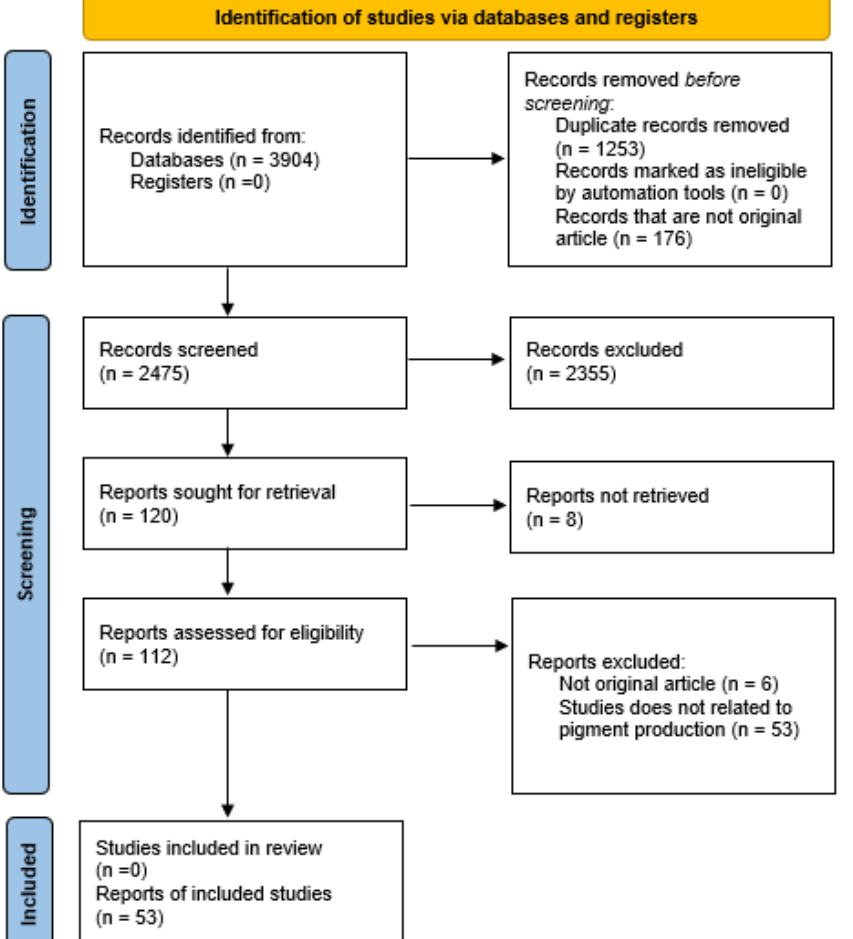
Figure 1. PRISMA flow diagram. Flowchart of systematic literature search according to PRISMA